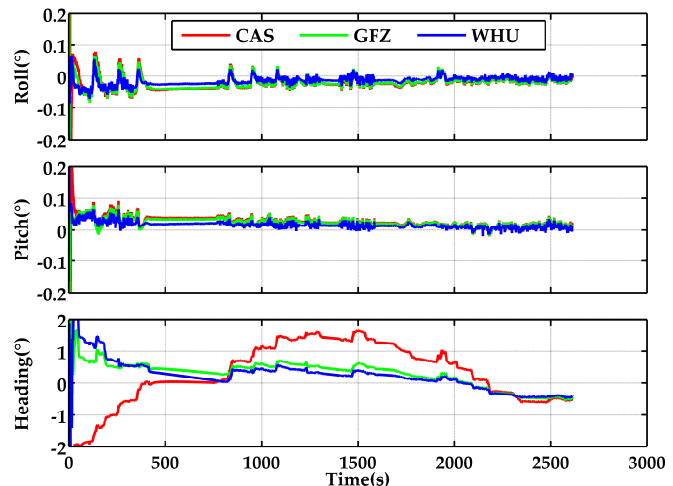
Figure 10. Attitude offsets of G + B SF-PPP/INS tight integration in roll, pitch, and heading directions using the real-time products from CAS, GFZ, and WHU, in terms of reference solutions (the start time is 195,453 s).